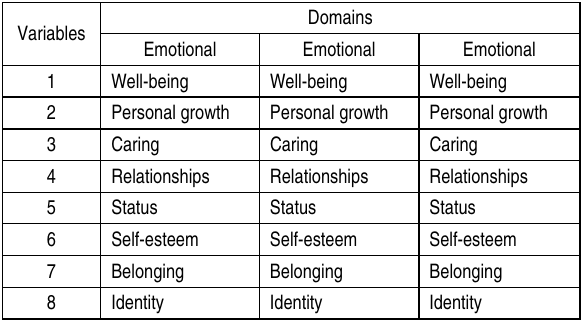
Table 1. Domains and variables 21 for VA and NVA aimed at uncovering hidden